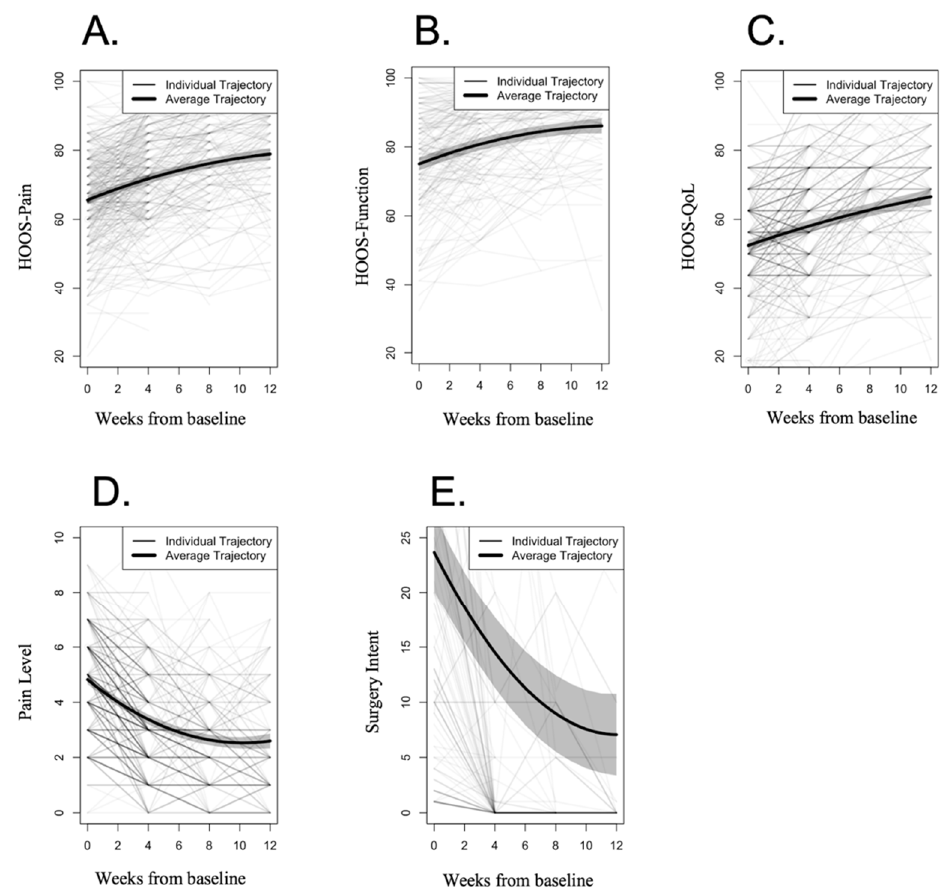
Figure 3. Longitudinal trajectories across time. Primary Outcomes: ( A ) HOOS-Pain; ( B ) HOOS- Function; ( C ) HOOS-QoL; ( D ) Pain Level; ( E ) Surgery Intent. Lighter lines represent individual trajectories (with darker lines indicating overlap of trajectories), while average trajectories calculated through LGCA are depicted in bold lines, with shadows representing 95% confidence intervals.